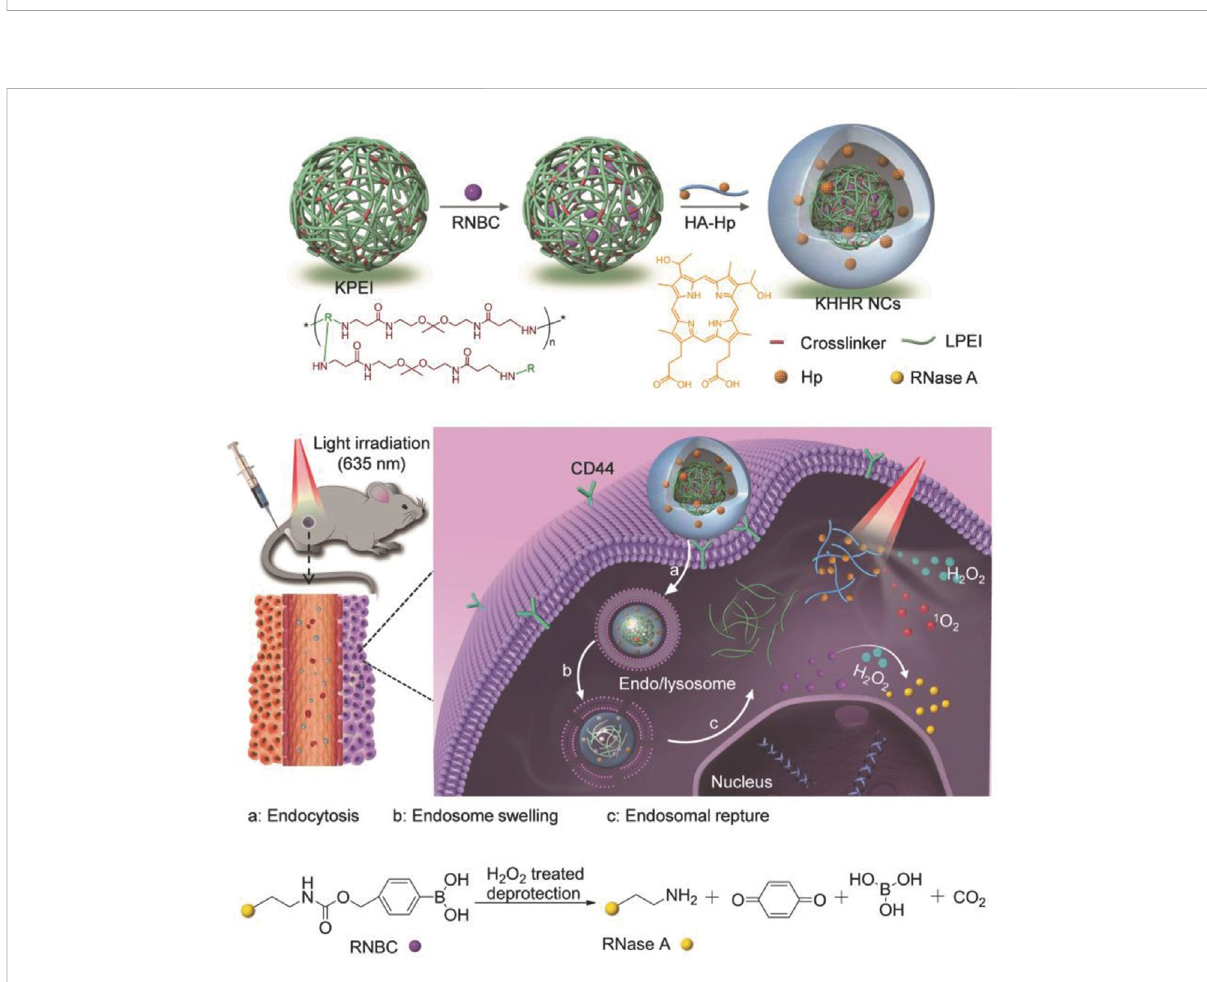
FIGURE 6 Schematic illustration of light-controlled protein delivery assisted by the “ all-functions-in-one ” nanocomplexes (NCs) toward synergistic cancer therapy. Reproduced with permission from Ref. (He et al.,